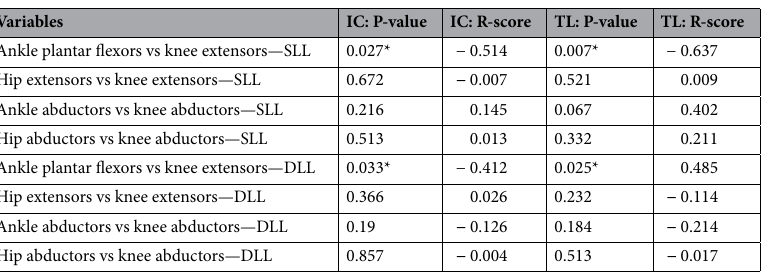
Figure 3. Means of each joint contribution to MEA (J/kg m) compared between different phases during SLL and DLL (IC: initial contact/TL: total landing). ( A ) Sagittal motion plane: knee extensors/ankle plantar flexors/ hip extensors. ( B ) Frontal motion plane: knee abductors/ankle abductors/hip abductors.